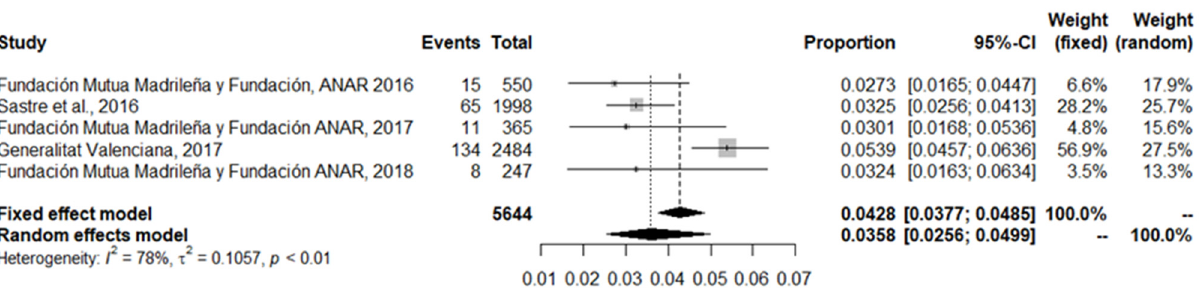
Figure 5. Forest plot of bullying victimisation among LGBT+ people studies.